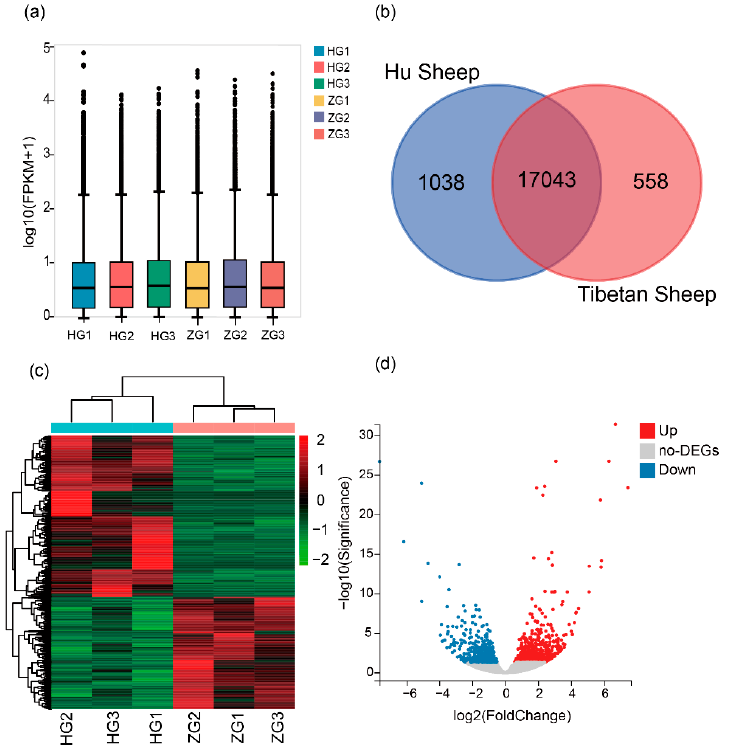
Figure 1. ( a ) Box plot of FPKM distribution in six samples. The abscissa represents the sample name, and the ordinate represents log10(FPKM+1). HG1, HG2, and HG3 are representative of the Hu sheep liver. ZG1, ZG2, and ZG3 are representative of Tibetan sheep liver. ( b ) Venn diagram of genes expressed in the livers of Hu sheep and Tibetan sheep. ( c ) Heat map of the DEGs cluster analysis. The different columns represent different samples, with different rows representing different genes. ( d ) Volcano plot displaying DEGs ( Q -value < 0.05) in the livers of Hu sheep and Tibetan sheep. Up, up-regulated DEGs; Down, down-regulated